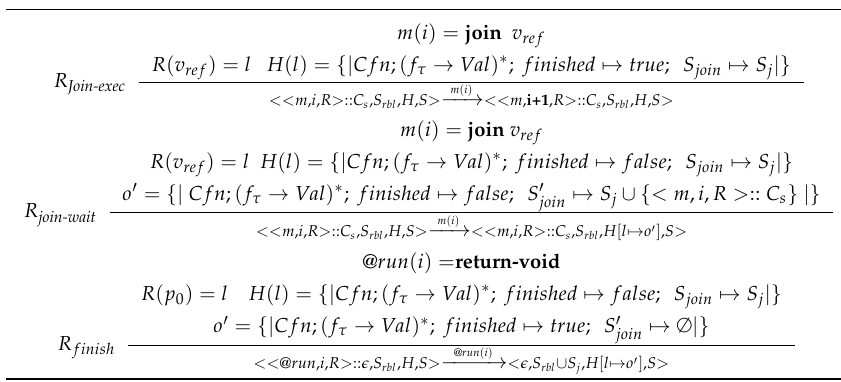
Table 11. Multi-threaded semantics: